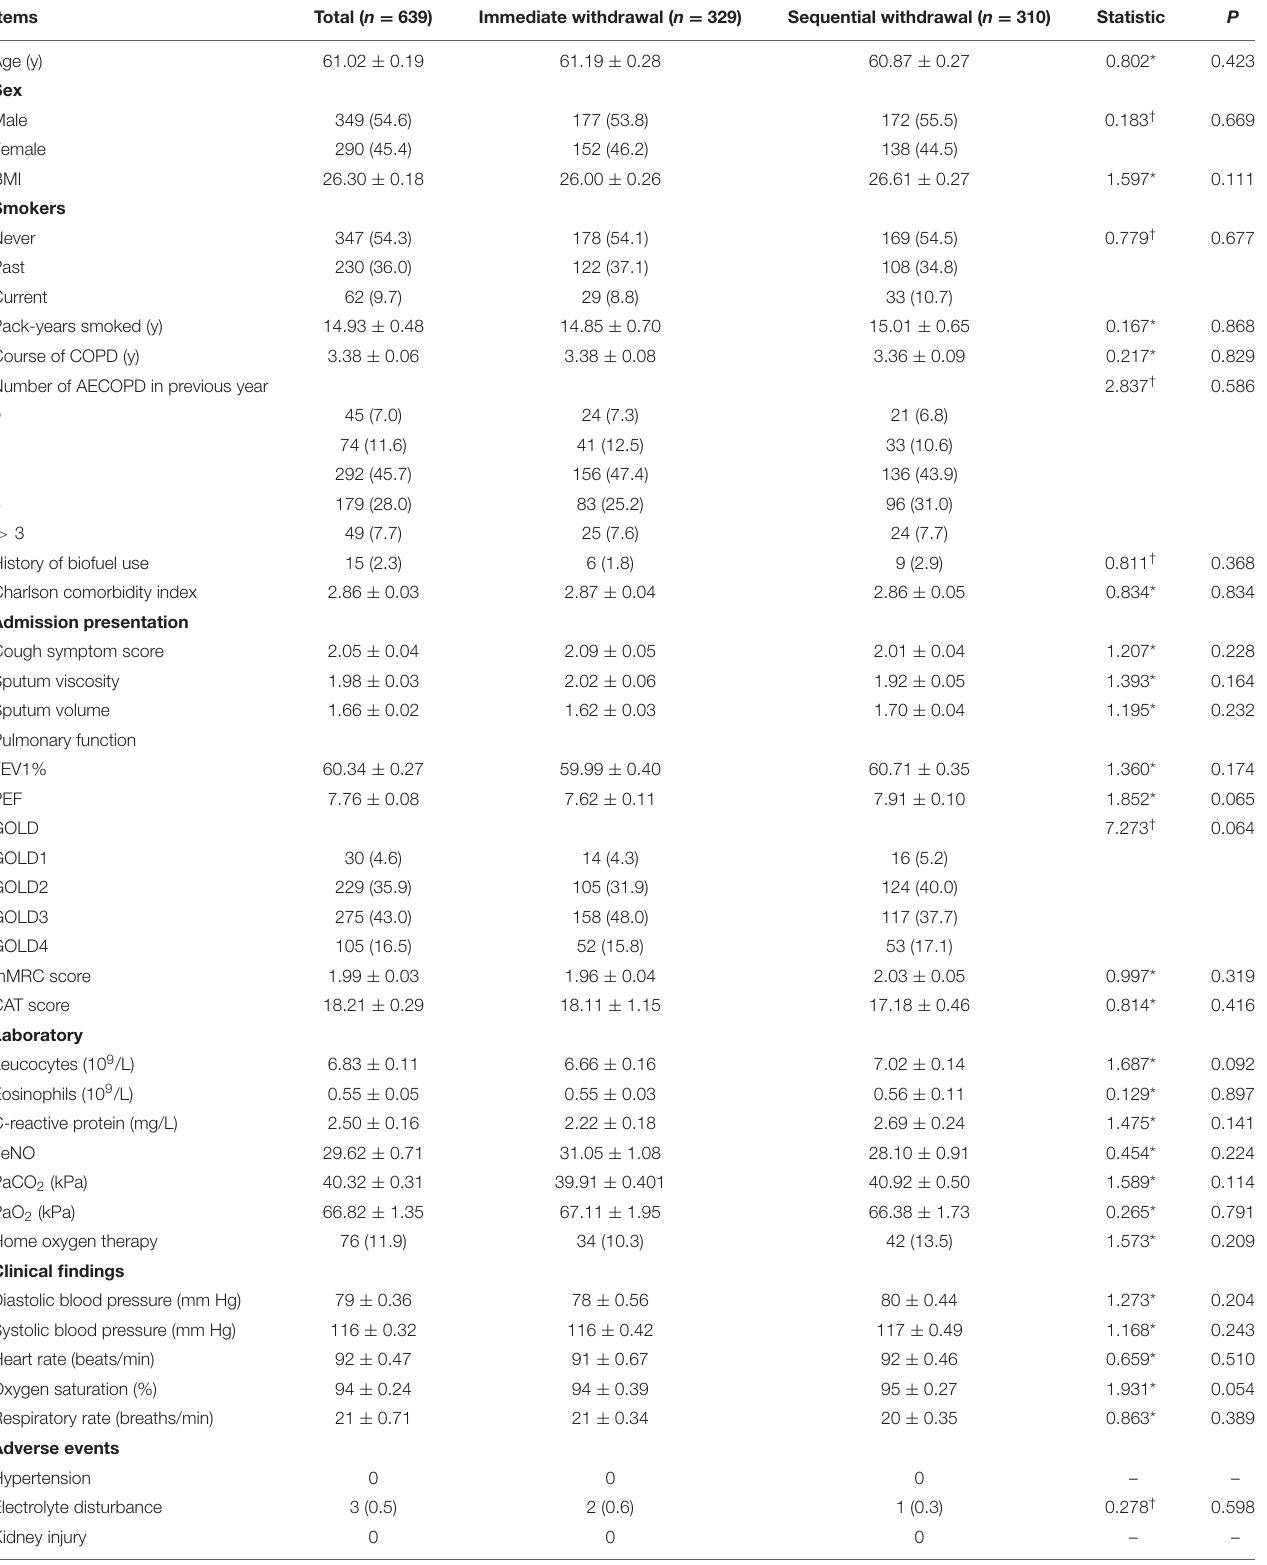
TABLE 1 | Baseline characteristics of the intention-to-treat